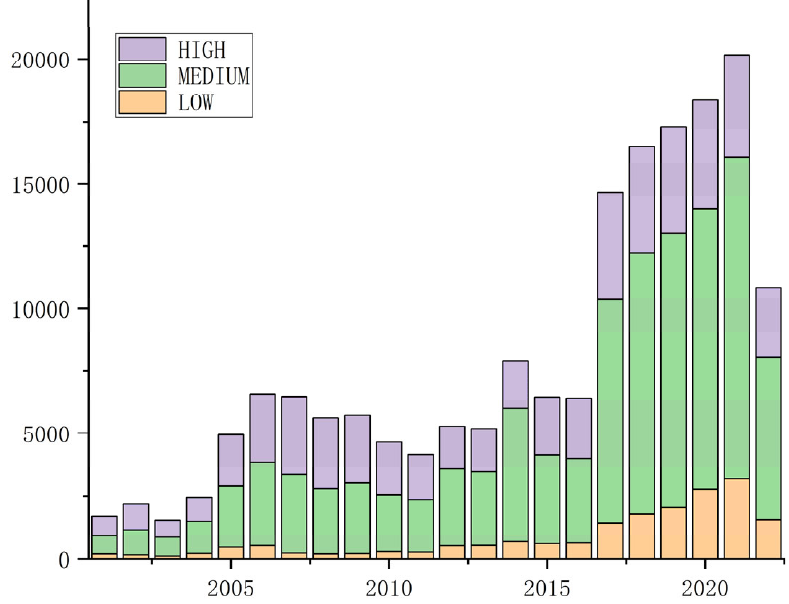
Figure 1. Vulnerability severity distribution over time(2000–2022).